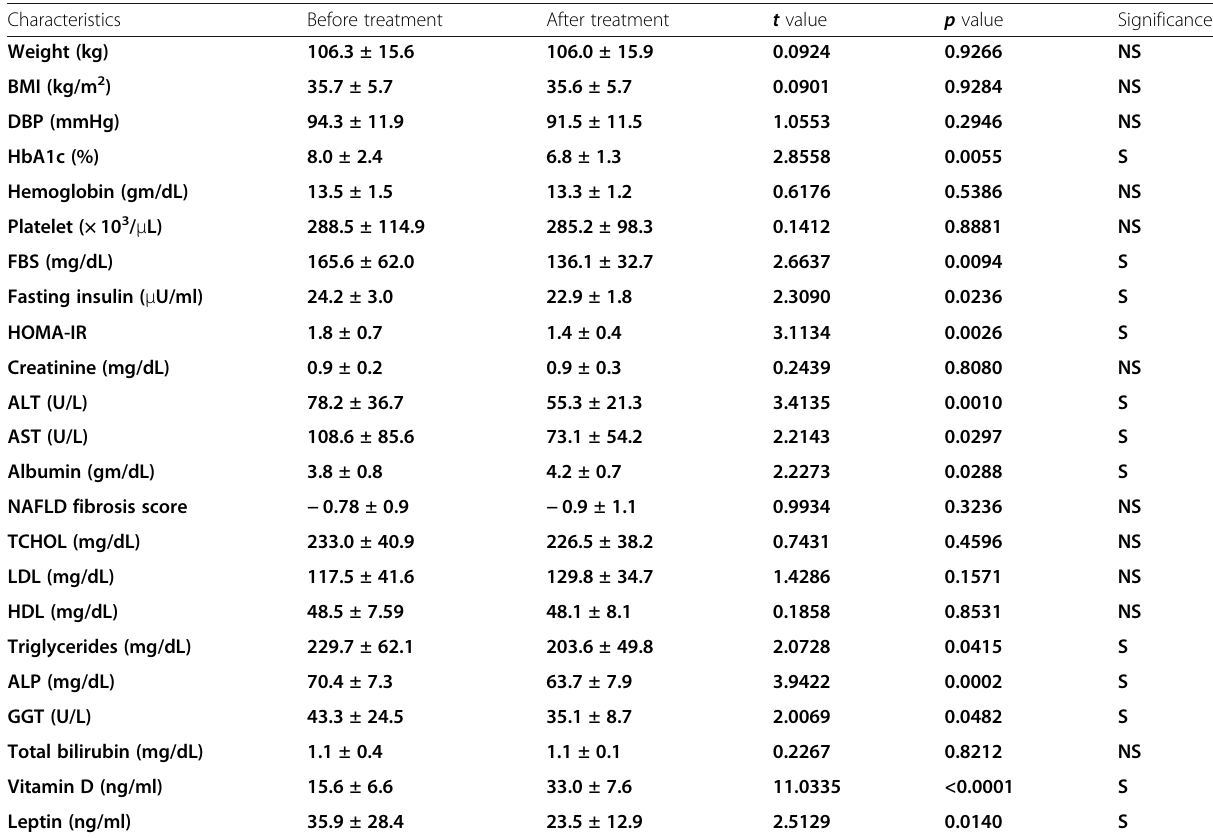
Table 2 Association of vitamin D supplementation with different demographic, laboratory, and metabolic parameters of patients with NASH Characteristics Before treatment After